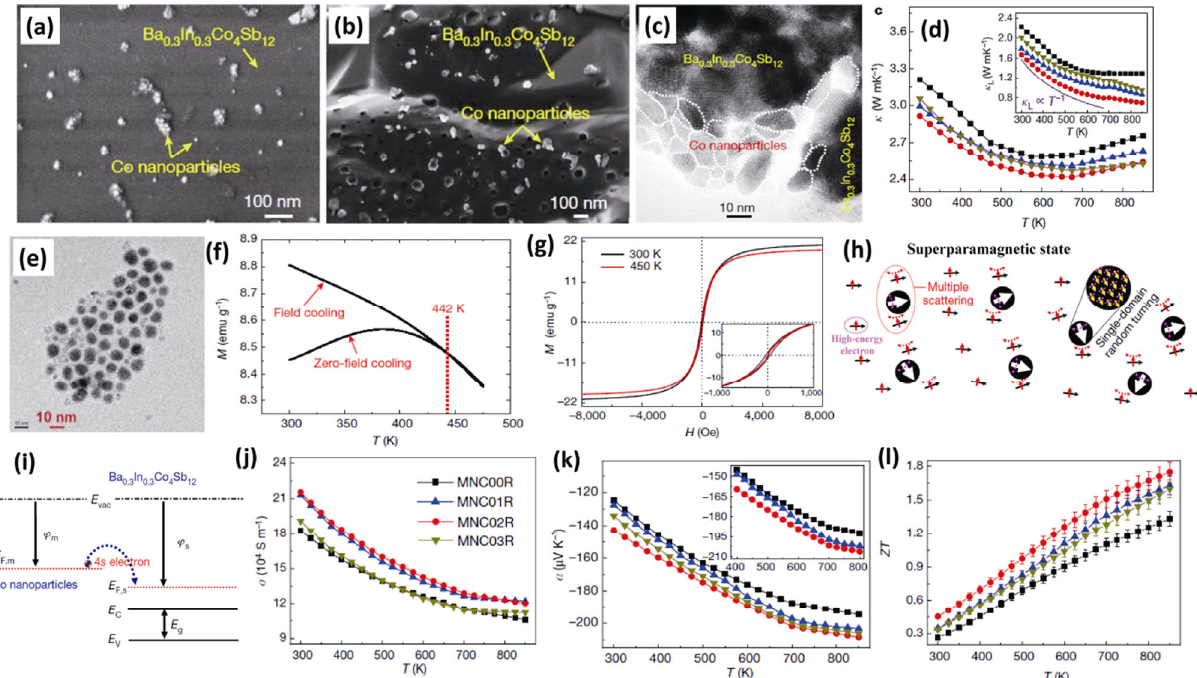
Fig. 13 Superparamagnetic enhancement of TE performance in x Co/Ba 0.3 In 0.3 Co 4 Sb 12 magnetic nanocomposite TE materials. (a–c) Microstructures of the as-prepared powders and bulk materials of x Co/Ba 0.3 In 0.3 Co 4 Sb 12 with x = 0.2% (MNC02R); (d) temperature dependences of thermal conductivity κ for x Co/Ba 0.3 In 0.3 Co 4 Sb 12 ; the inset in (d) shows the temperature dependence of lattice thermal conductivity κ L ; (e) TEM image of the Co nanoparticles (diameters of 5–10 nm); (f) ZFC and FC M – T curves of Co nanoparticles; (g) M – H curves at 300 and 450 K of Co nanoparticles; (h) multiple scattering of electrons (indicated by the small red dashed arrows) as a result of the random turning of magnetic domains (indicated by the small purple dashed arrows) within the superparamagnetic Co nanoparticles; (i) schematic of the charge transfer of 4s electrons from the Co nanoparticles to the matrix; E vac is the vacuum energy, E F,m and E F,s are the Fermi levels of the Co nanoparticles and the matrix, respectively, E C is the energy of the conduction band minimum, E V is the energy of the valence band maximum, and E g is the bandgap; φ m and φ s are the work functions of the Co nanoparticles and the matrix, respectively; temperature dependences of (j) electric conductivity σ , (k) Seebeck coefficient α , and (l) figure of merit ZT for x Co/Ba 0.3 In 0.3 Co 4 Sb 12 ; the inset in (k) highlights the abnormal temperature dependence of the Seebeck coefficient for MNC01R (blue). Reproduced with permission from Ref. [22], © Macmillan Publishers Limited, part of Springer Nature